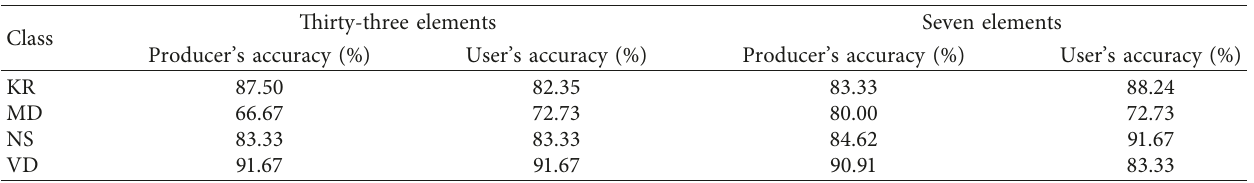
Table 6: Producer’s and user’s accuracies for the classification of the four soil classes, nonvitrified dung (NVD), midden (MD), nonsites (NS), and vitrified dung (VD), derived using all variables (33 elements) and the most important variables (7 elements).